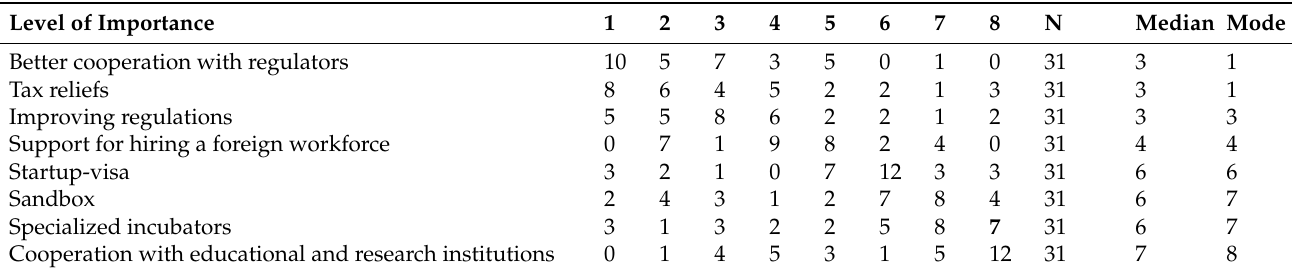
Table 2. Answers to the question of what measures will help the further development of the respon- dent’s company and/or the Latvian FinTech sector.